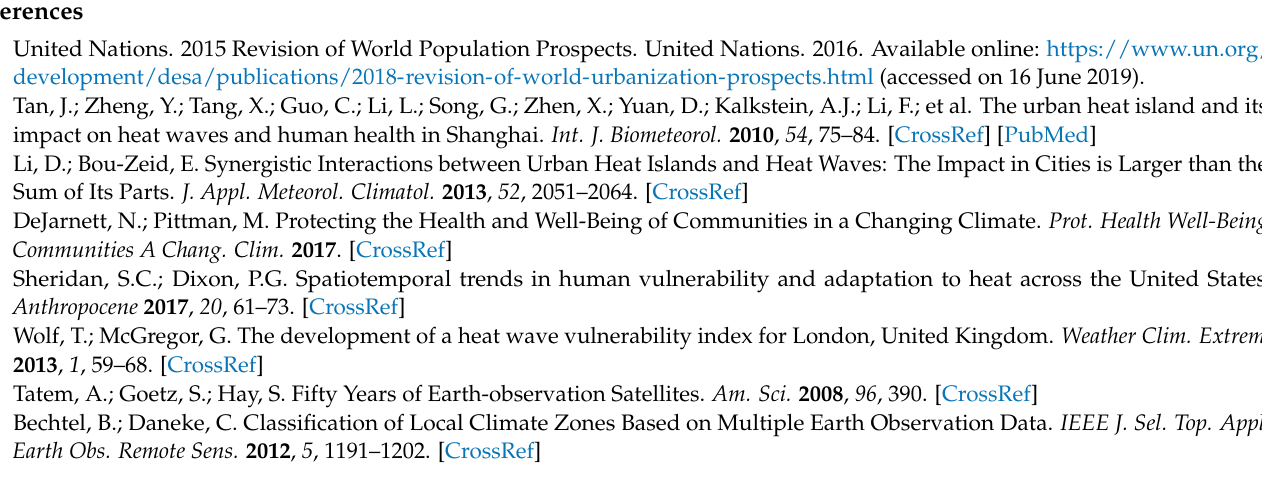
validation results—contingency matrix, Table S6: WUDAPT test validation results—contingency ma- trix, Table S7: Google Earth Engine (GEE) method validation results—contingency matrix, Figure S8. Landsat 8 TIRS image (color scale applied), 30 July 2018—Oslo area, Figure S9: USGS LST raster generation workflow, Figure S10. Landsat 8 TIRS image (color scale applied), 25 August